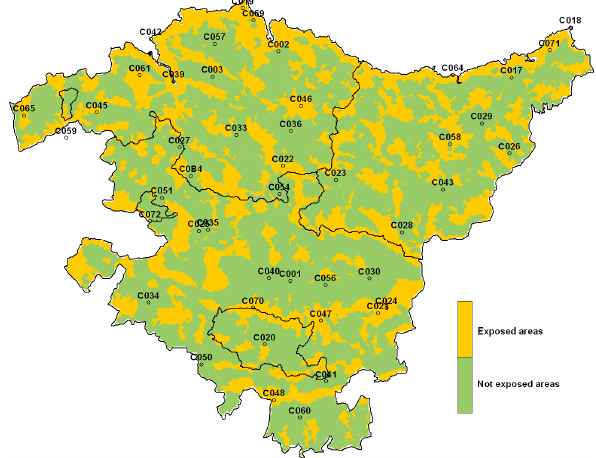
Figure 2. Snow warning areas and heated rain gauge distribution. 2 percentile 95 / 99 / 100 for yellow / orange / red levels, respec- tively, using temperature series for the same representative weather stations. Finally, in the high temperature persis- tence event, a combination of daily max / min temperatures are considered taking into account the 95 percentile; yel- low / orange / red level are considered when this situation re- mains for 1–2 days, 3–4 days or more than 5 days respec- tively (Table 2).